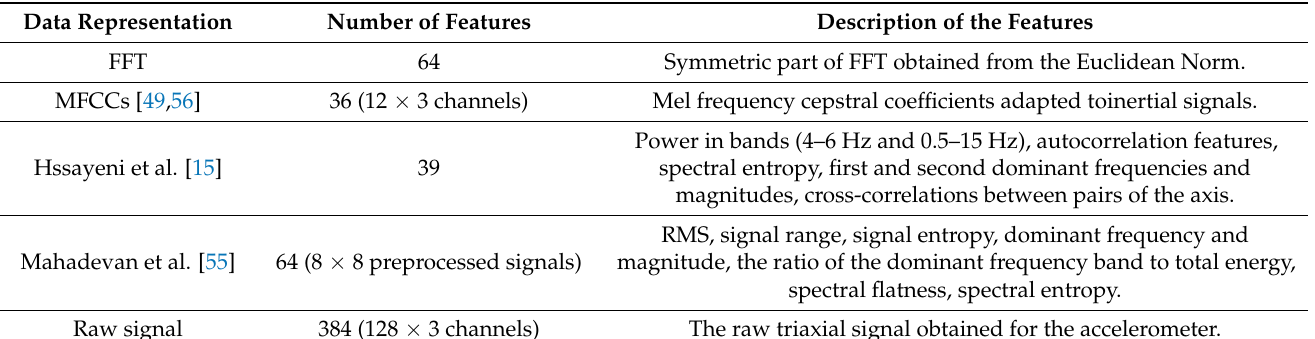
Table 3. Summary of the data representations used in the tremor detector.